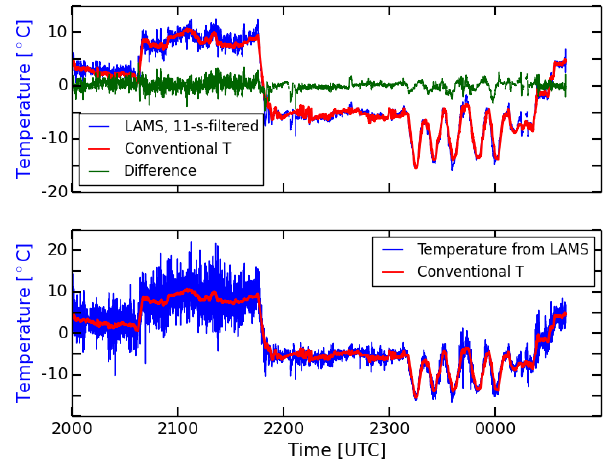
Figure 8. Temperature determined from LAMS plotted with the standard measurement of temperature for a flight segment from the C-130 flight of 17 November 2011, and the difference between the two measurements. The bottom panel shows the 1Hz measurements from LAMS; in the top panel, these have been smoothed by an 11s box average.